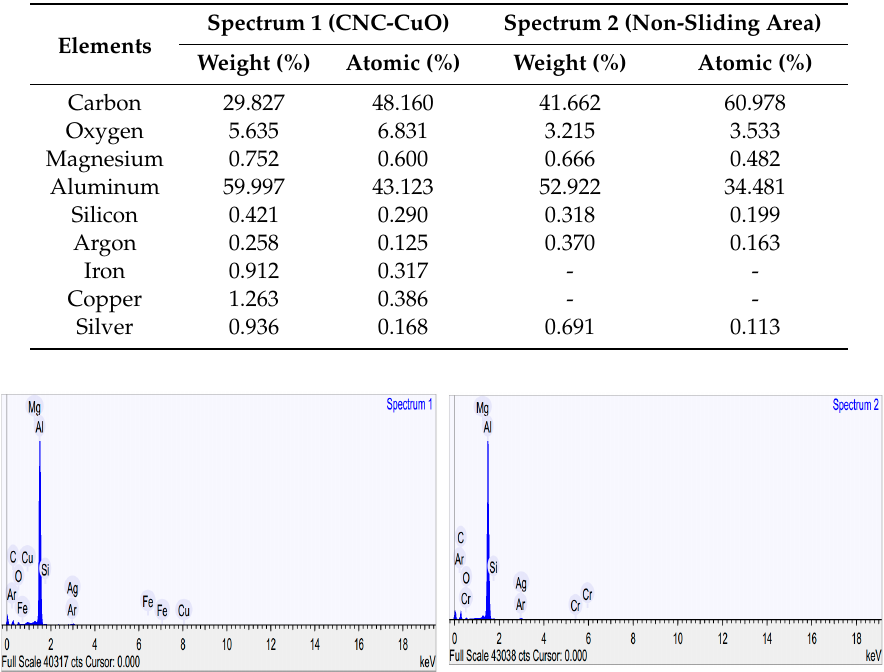
Figure 21. Sliding and non-sliding area of contact. Table 2. Percentage of the element according to EDX spectrum.